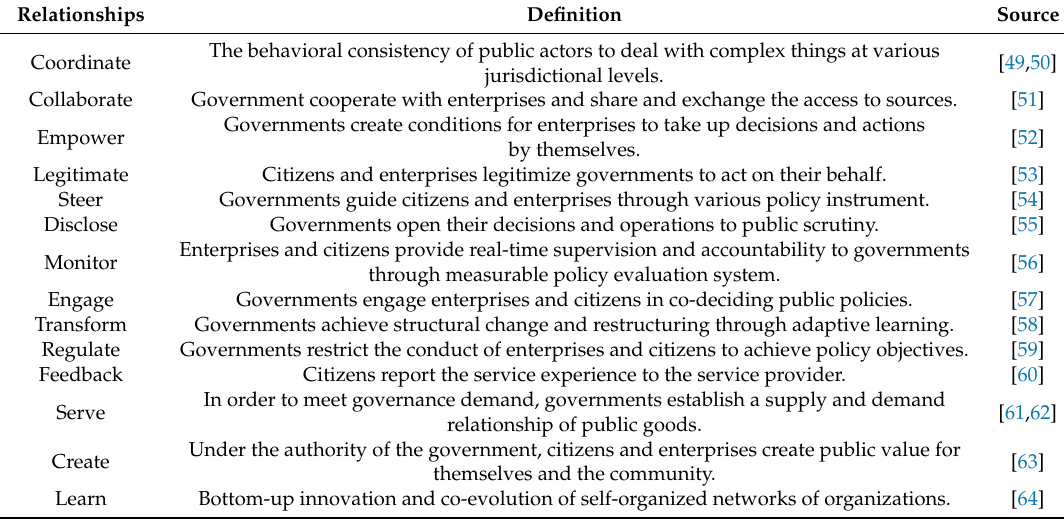
Table 1. Summary and definition of government–enterprise